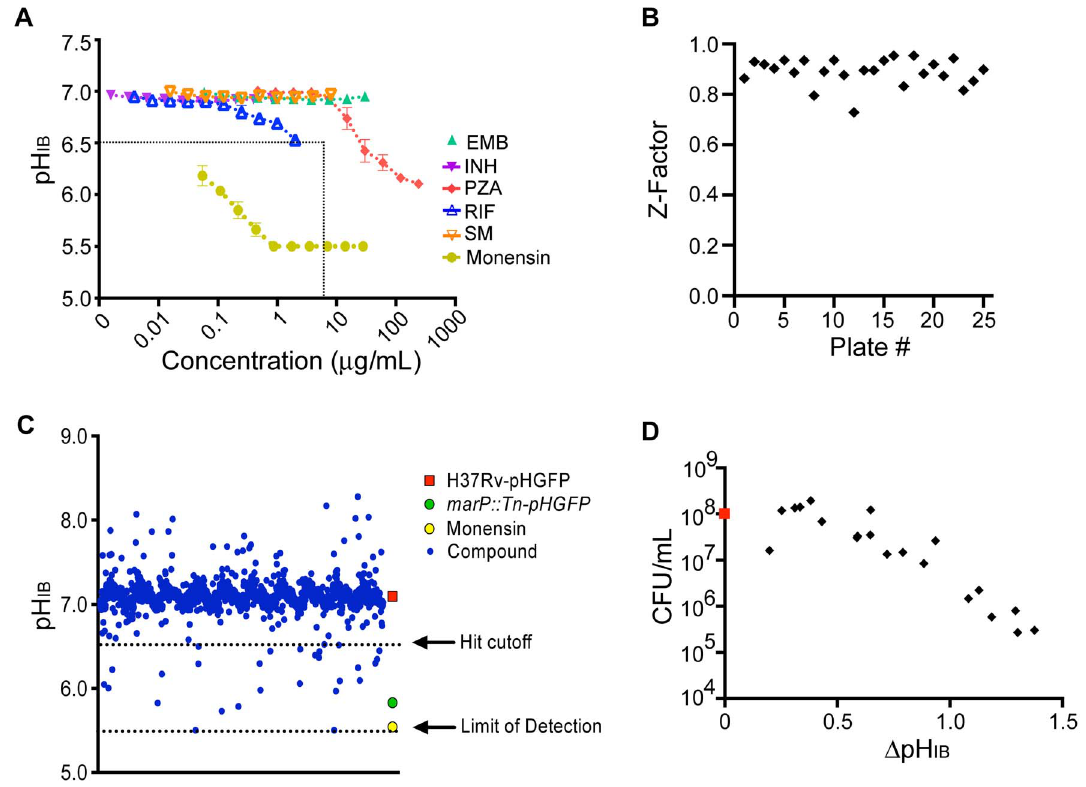
Figure 1. Effects of antibiotics, monensin, and other natural products on pH IB of Mtb . (A) H37Rv-pHGFP was treated with vehicle control DMSO, antibiotic, or monensin in phosphate citrate buffer pH 4.5 and pH IB measurements were taken after two days of exposure. pH IB of marP::Tn- pHGFP dropped to pH 5.5 under the assay conditions. Dotted black lines indicate hit cutoff pH and HTS screening concentration. Means 6 standard deviations of triplicate experimental samples are shown from one experiment, representative of three. (B) Z-factor values were calculated from DMSO treated H37Rv-pHGFP and marP::Tn- pHGFP controls located on each plate screened. (C) pH IB measurements for H37Rv-pHGFP exposed to 1,980 natural products and controls after two days at pH 4.5. (D) Correlation between change in pH IB and survival of Mtb- pHGFP after a two day exposure to 20 hit compounds at pH 4.5. Results represent two independent experiments, each performed in duplicate. Untreated, DMSO control in red.